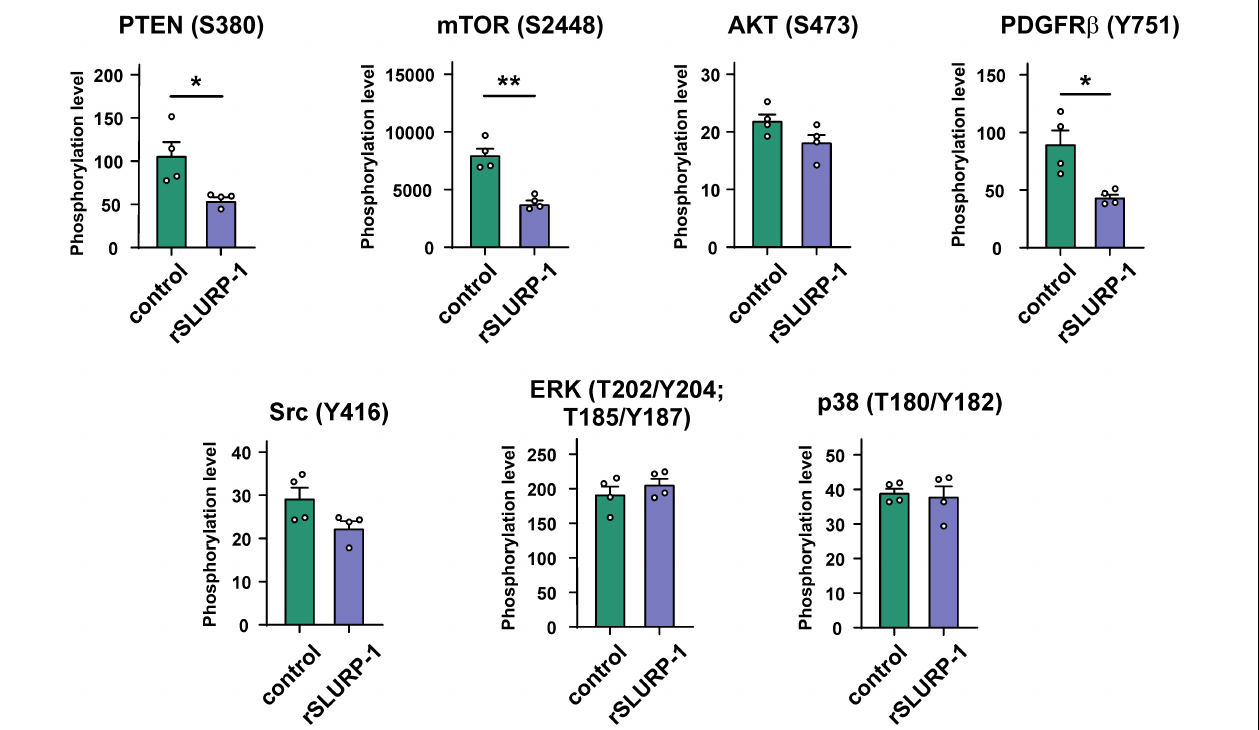
FIGURE 1 | Effect of rSLURP-1 on phosphorylation of the Akt/mTOR and MAP/ERK pathways participants in A549 cells. A549 cells were incubated for 48 h with 1 µ M of rSLURP-1; and PTEN (S380), AKT (S473), mTOR (S2448), PDGFR β (Y751), Src (Y416), ERK (T202/Y204; T185/Y187), and p38 (T180/Y182) phosphorylation was detected by Bio-Plex magnetic beads assay. Data are presented as mean ± SEM, n = 4; * ( p < 0.05) and ** ( p < 0.01) indicate the significant difference by a two-tailed t